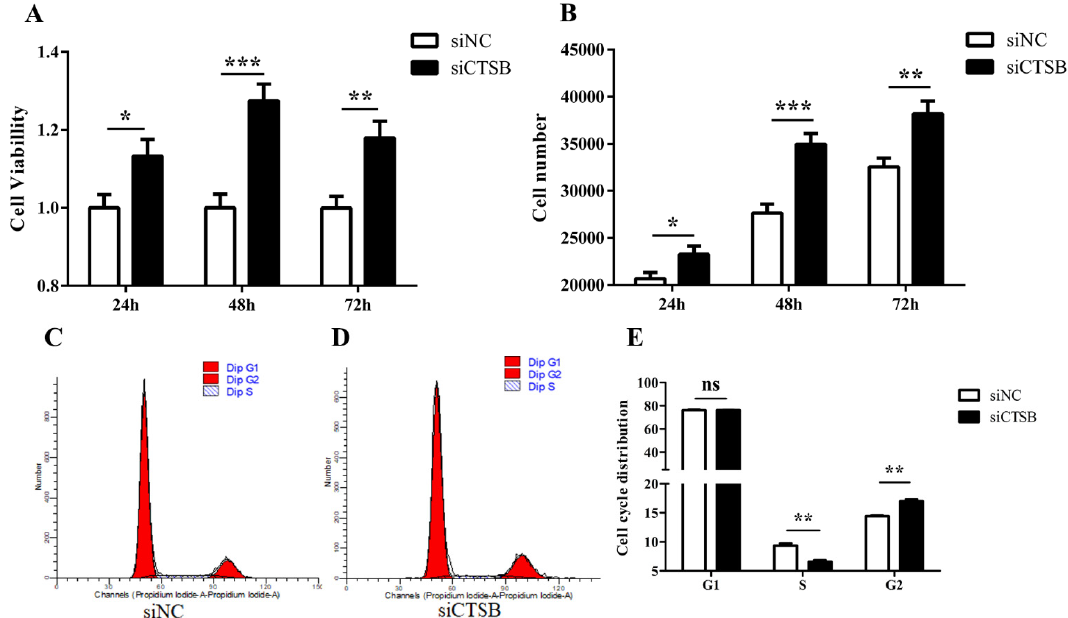
Figure 3. In vitro, CTSB depletion increased proliferation and modulated cell cycle progression in mouse GC. ( A , B ) The CCK-8 kit was used to assess the proliferation rate of GCs transfected with siCTSB and NC at 24, 48, and 72 h. The viability of the cells was determined by the concentration of formazan dye, a cell viability indicator. A multimode plate reader with absorbance at 450 nm was used to read the plates, and cell numbers were counted using an automated cell counter. ( C – E ) Mouse GC was transfected with siCTSB and incubated for 48 h before being saturated in PI, and the FACS and GC cycle were determined. All results are presented as means ± SEM. Significance difference, * p < 0.05, ** p < 0.01, *** p < 0.001; siCTSB, cathepsin B siRNA; GC, granulosa cells; siNC, negative control siRNA; ns, non-significant.